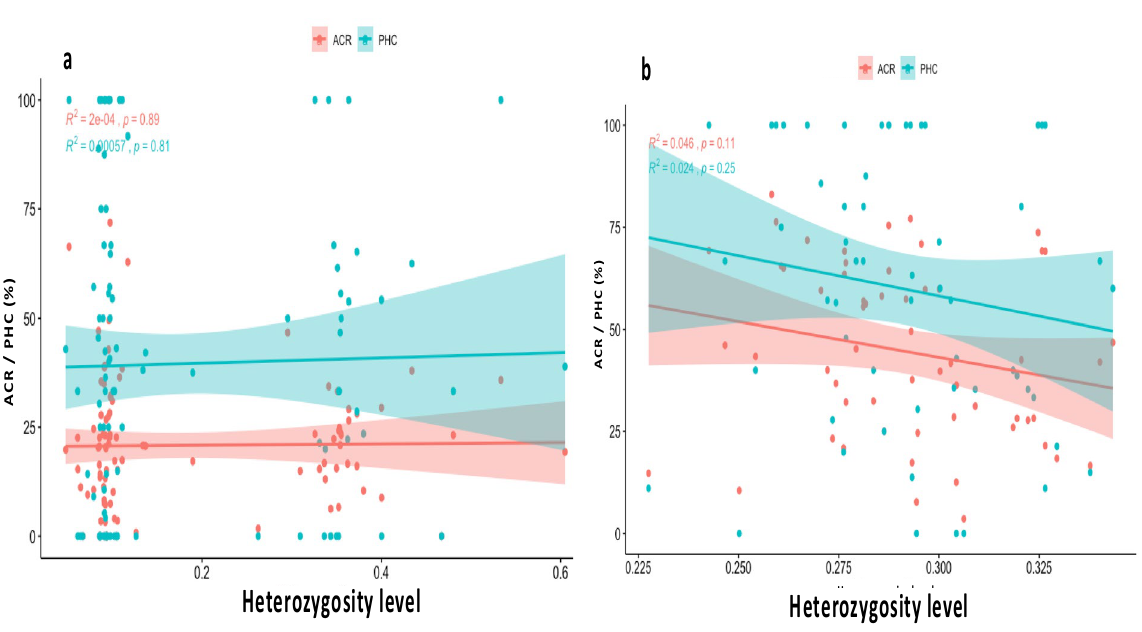
Figure 6. Heterozygosity level of (a) D. rotundata and (b) D. alata parental genotypes, and influence on the average crossability rate (ACR) and the percentage high crossability